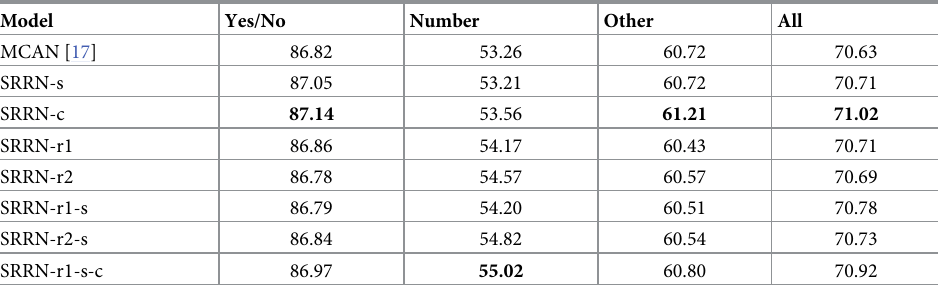
Table 1. Performance of different SRRN variant models on VQA 2.0